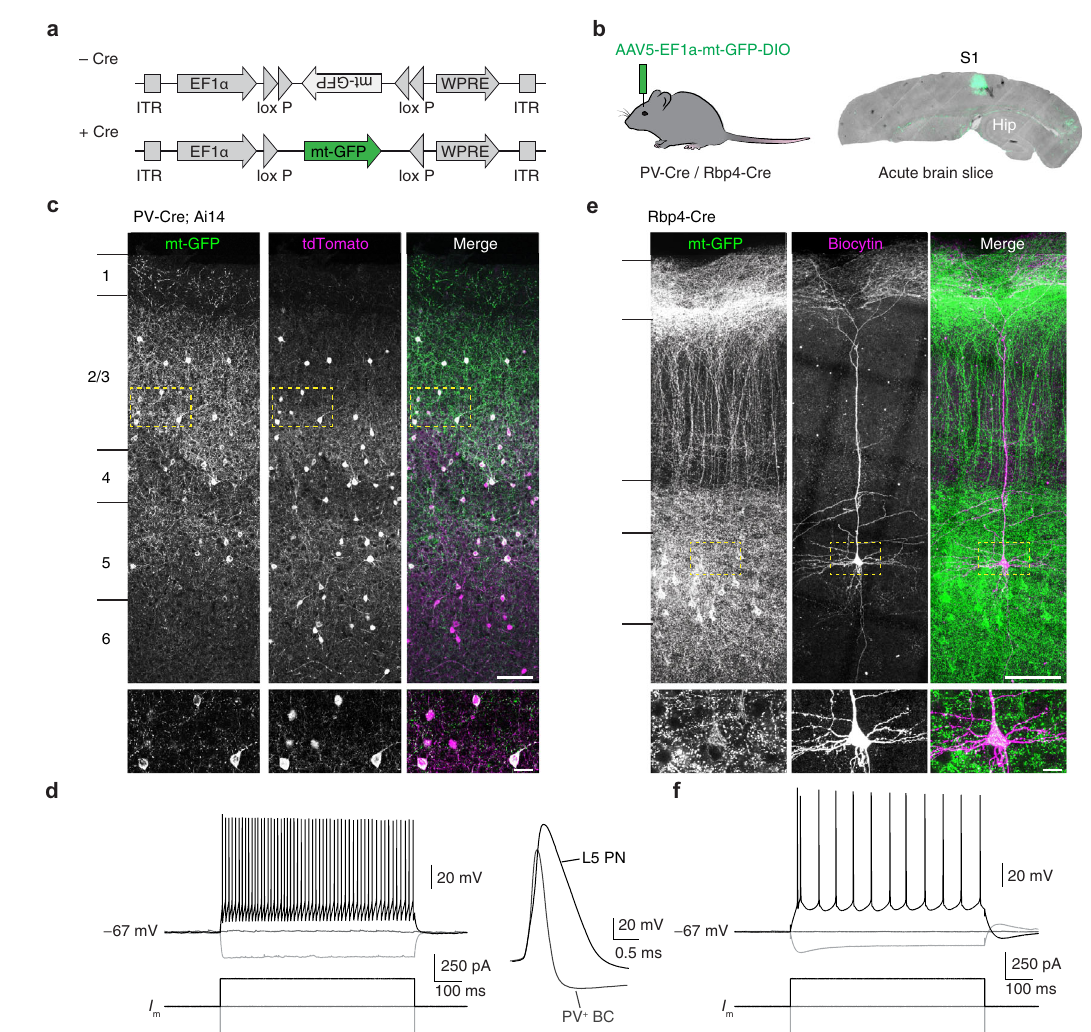
Fig. 1 | mt-GFP expresses in a Cre-dependent manner. a Schematic of the AAV construct design. Mitochondria-targeted green fl uorescent protein (mt-GFP) requires Cre recombination for expression under the elongation factor-1 alpha (EF1 α ) promoter. b PV-Cre; Ai14 or Rbp4-Cre mice were injected with AAV5-EF1a- mt-GFP-DIO. Hip, hippocampus. c Expression in PV-Cre; Ai14 mice results in high overlapbetweentdTomatoand mt-GFP.Scalebar indicates 100 µ m. Dashed boxes indicate area depicted byinsets atbottom, scalebarindicates 5 µ m.Similarresults wereobtained in>10mice. d Left:Example tracesofactionpotentialsinamt-GFP +